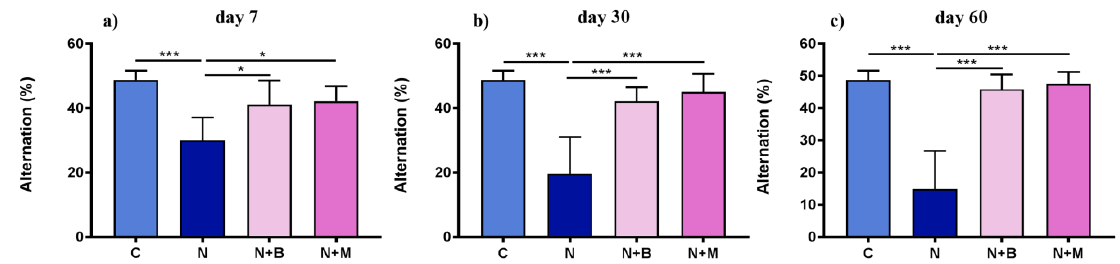
Figure 6. Percentage of alternation in Y-maze. Animals ( n = 6) were treated for 60 days with (N) noise or left untreated (C). Mesedin (M) and beditin (B) were injected daily i.p. to the rats exposed to chronic noise (N + M and N + B, respectively). One-way ANOVA with Sidak’s multiple comparison test, * p < 0.05, *** p < 0.001. The mean ± SEM values of percentage of alternations on days 7, 30, and 60 of noise exposure and mesedin/beditin are shown in ( a ), ( b ), and ( c ), respectively.